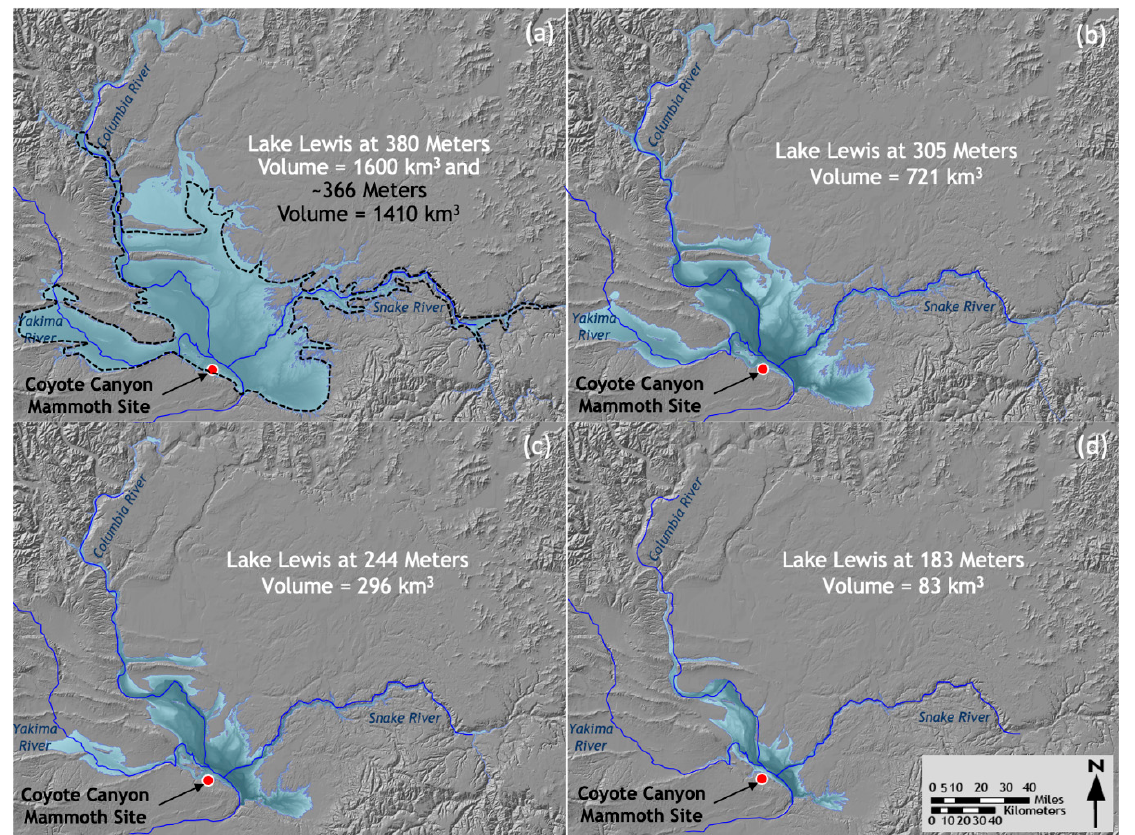
Figure 2. Schematic of the extent of hydraulically ponded flood waters of transient Lake Lewis assuming static flood stages at 380 m asl ( a ), 305 m asl ( b ), 244 m asl ( c ), and 183 m asl ( d ) [17]. Note that a flood stage of about 366 m asl, outlined in ( a ), would yield a volume of 1410 km 3 [11].